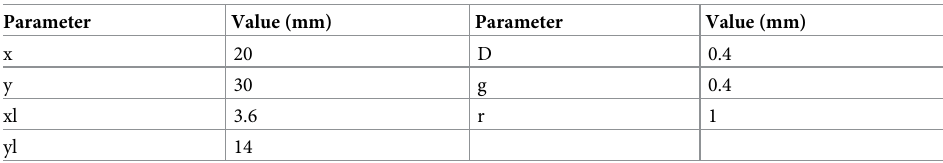
Table 1. Parameters of the